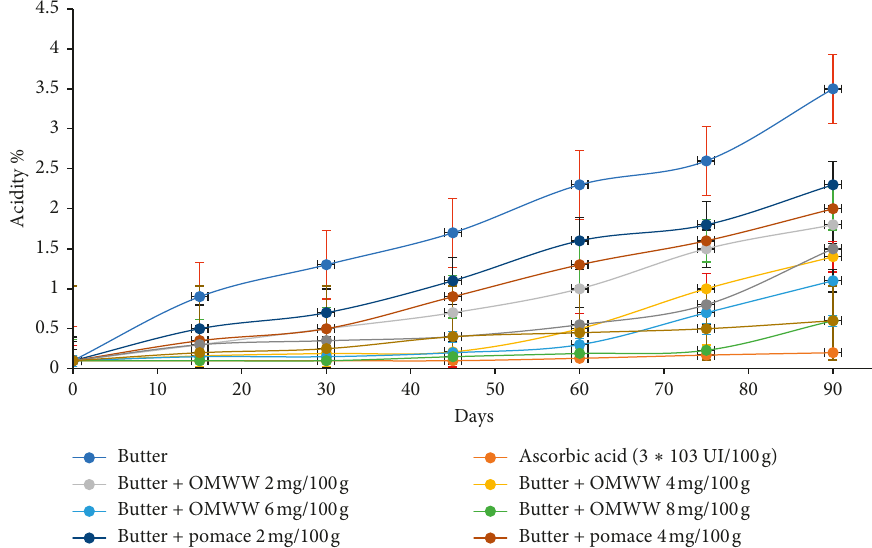
Figure 4: Evolution of the acidity as a function of the storage time of butter at 25 ° C.